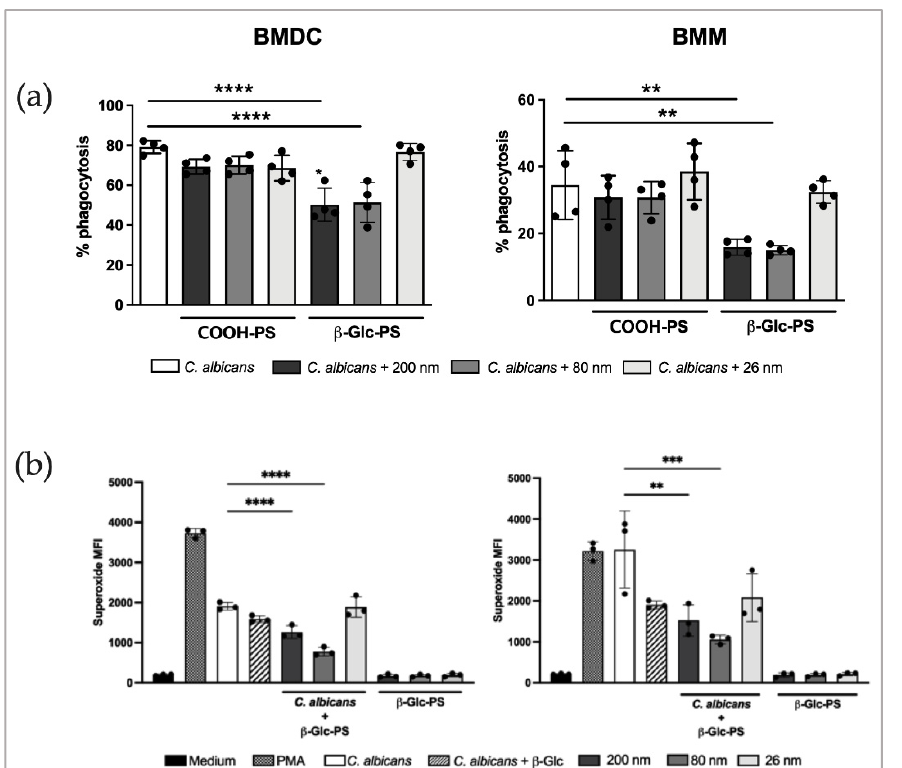
Figure 5. Analysis of β -Glc-PS treatment on phagocyte function. ( a ) Quantification of yeast phagocytosis by BMDC and BMM was assessed by flow cytometry. Immune cells were incubated for 30 min with heat-killed C. albicans SC5314 (MOI 1 BMDC/BMM: 5 yeasts) labeled with Sytox Green plus 80 nm β -Glc-PS (10 μ g/mL) and stained with Propidium Iodide prior to analysis. ( b ) Production of ROS was assessed by using Superoxide Detection kit. BMM and BMDC incubated for 15 min with heat-killed C. albicans SC5314 at a MOI 1:5, in the presence of 200, 80 or 26 nm β -Glc-PS NP (10 μ g/mL) and analyzed by flow cytometry. Samples were acquired on FACSCantoII (BD Biosciences) and data analyzed with FlowJo software (Version 10.0.7). Bars correspond to means ± SD. Each condition was set in triplicate. Each black dot corresponds to the mean value of the three technical replicates of an independent experiment. One-way ANOVA with Tukey’s post Hoc test, (** p < 0,01; *** p < 0.001; **** p < 0.0001). The complete statistical analysis data is presented in the supplementary material (Table S2).